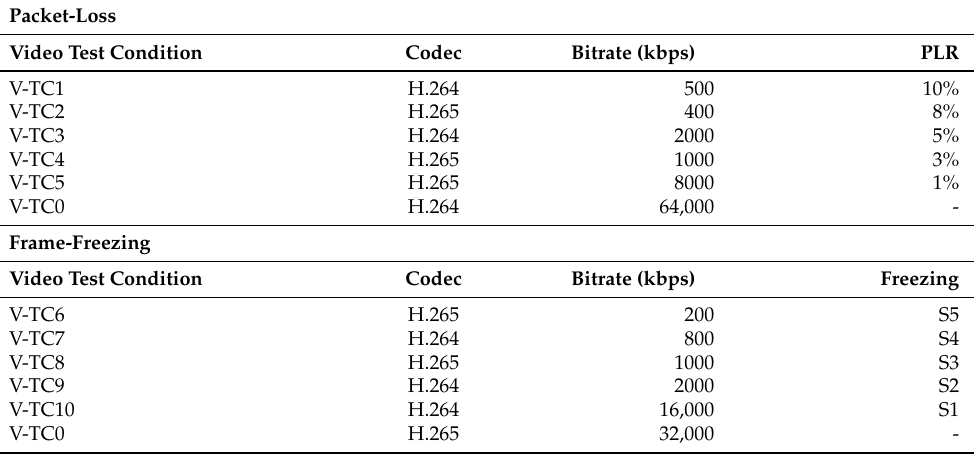
Table 10. Video Test Condition (V-TC) corresponding parameters used in Experiment 1, 2, and 3.